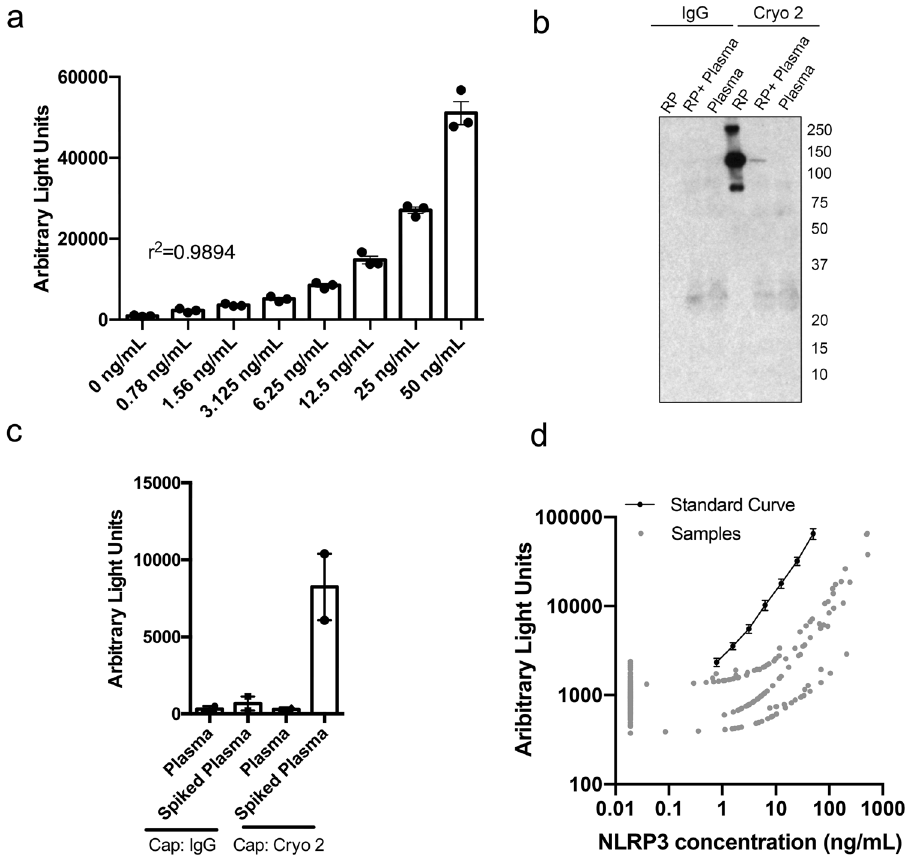
Fig. 2 Development of an electrochemiluminescent-based assay for the detection of in fl ammasome-related protein NLRP3. Anti-NLRP3 antibodies were tested in different capture and detection antibody pairing orientations in 96-well electrode-containing immunosorbent plates (Meso Scale Diagnostics (MSD), Rockville, MD) for their ability to detect NLRP3 recombinant protein. Once an antibody pair was found, the capture antibody was biotinylated and assay conditions were optimized using streptavidin-coated 96-well electrode-containing immunosorbent plates. a The antibody pair identi fi ed was able to detect recombinant NLRP3 protein in 1% BSA ( r 2 = 0.9894) down to a concentration of 0.78 ng/mL. R 2 was calculated using linear regression. b NLRP3 detection was con fi rmed through immunoprecipitation (IP), where the capture antibody was used as the pull-down antibody and the detection antibody was used as the immunoblotting antibody. c Clean plasma or plasma spiked with 12.5 ng/mL of recombinant NLRP3 protein was run on the optimized electrochemiluminescent assay using biotinylated mouse IgG or biotinylated Cryo 2 as the capture antibody in order to ensure antibody-pair speci fi city and low non-speci fi c binding. d NLRP3 protein concentration was plotted against electrochemiluminescent read-out (Arbitrary Light Units) for the representative standard curve and all samples analyzed. Axes are on the logarithmic scale. Samples classi fi ed as “ non-detectable ” were imputed by taking the minimum positive value divided by 2. Error bars in a and c represent